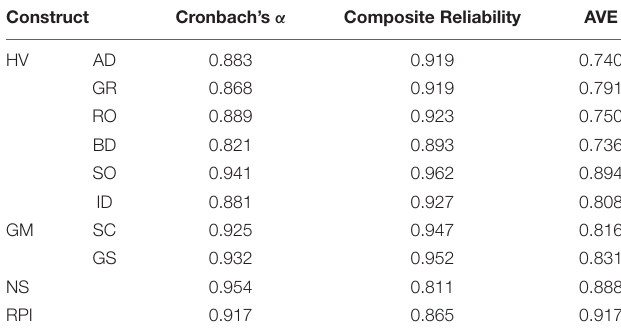
TABLE 4 | Reliability and validity of the first-order